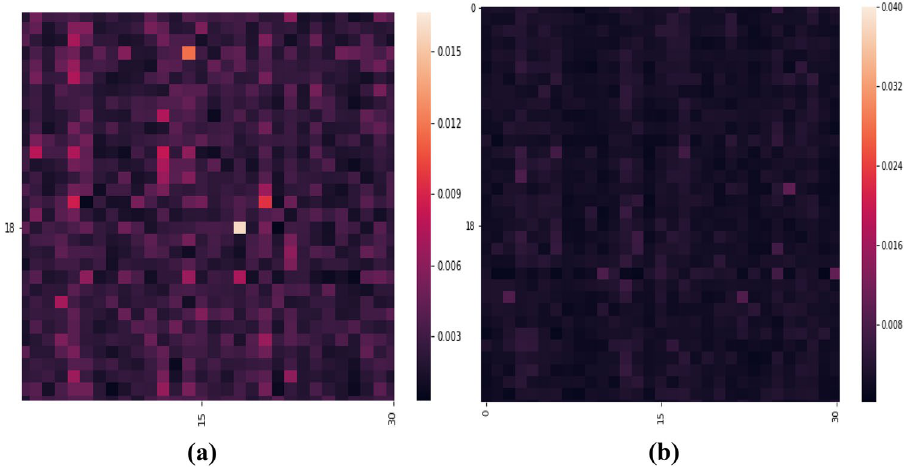
Figure 1. Feature ranking matrices of 30 companies out of 375 companies: ( a ) 2008 ( b ) 2011. Here, we chose 30 companies to show finer map. The light shaded color in heat map indicates the companies which influence more to other companies. The influences of companies during European sovereign debt crisis were higher than global financial